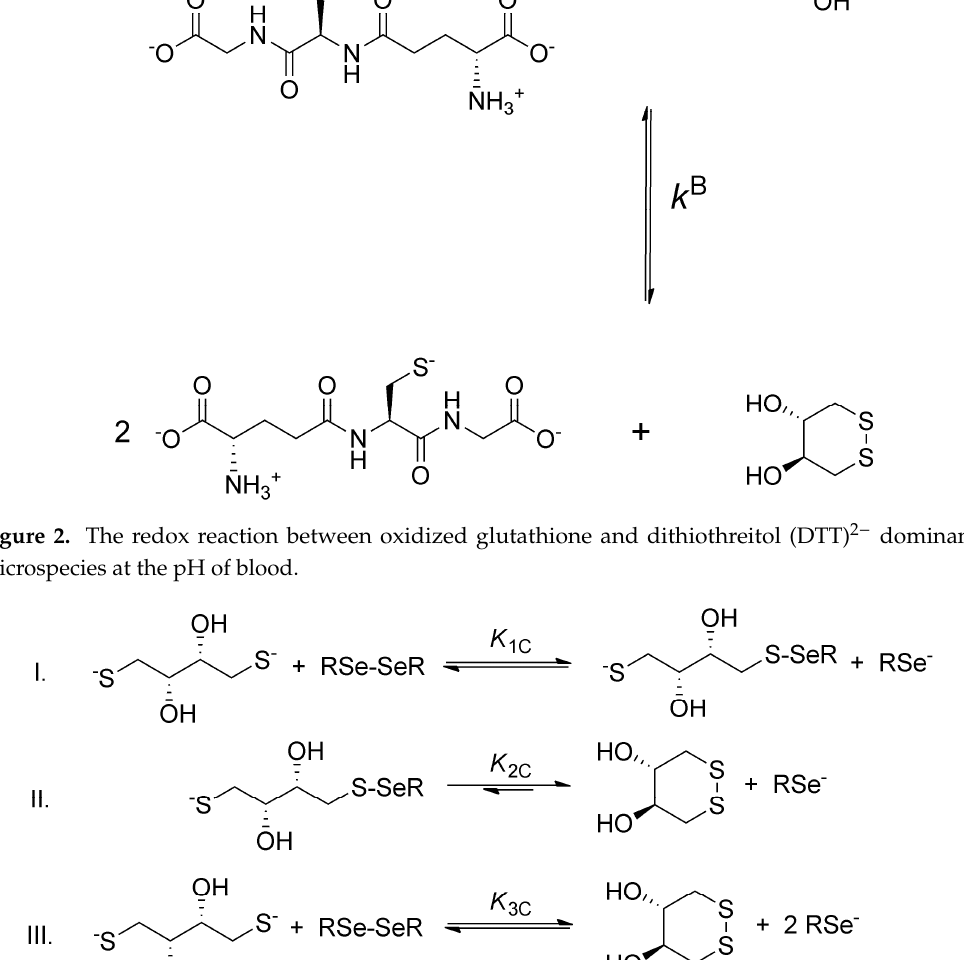
Figure 3. The two-step redox equilibria between a diselenide compound and DTT 2 − (reaction I and II) followed by their aggregated one-step net reaction (III). Identical reaction schemes are applicable for disulfide analogues. The arrow in reaction II indicates the low probability of formation of the sulfur– selenium bridge.